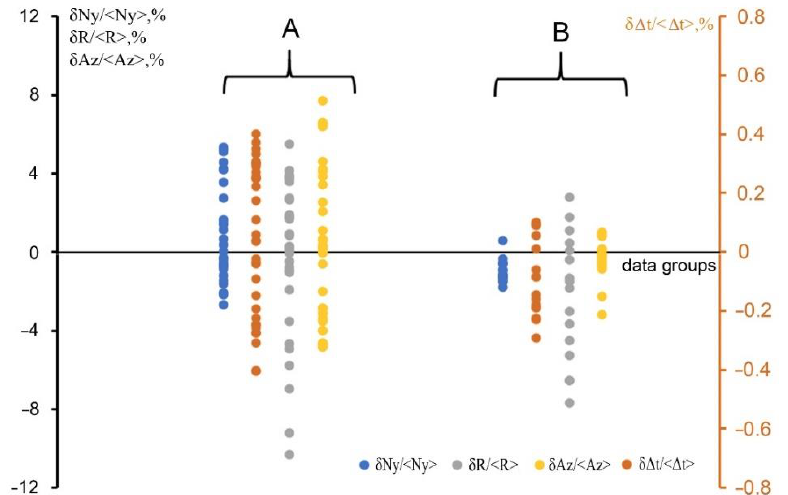
Figure 8. Evolution of fluctuations 𝛿𝑁 𝑦 /< 𝑁 𝑦 >, 𝛿𝑅/< 𝑅 >, 𝛿𝐴 𝑍 /< 𝐴 𝑍 >,δ∆𝑡/< ∆𝑡 > (in % from averaged value) during the experimental session: ( A ) before 30–days, ( B ) after 30–days from the start of monitoring.